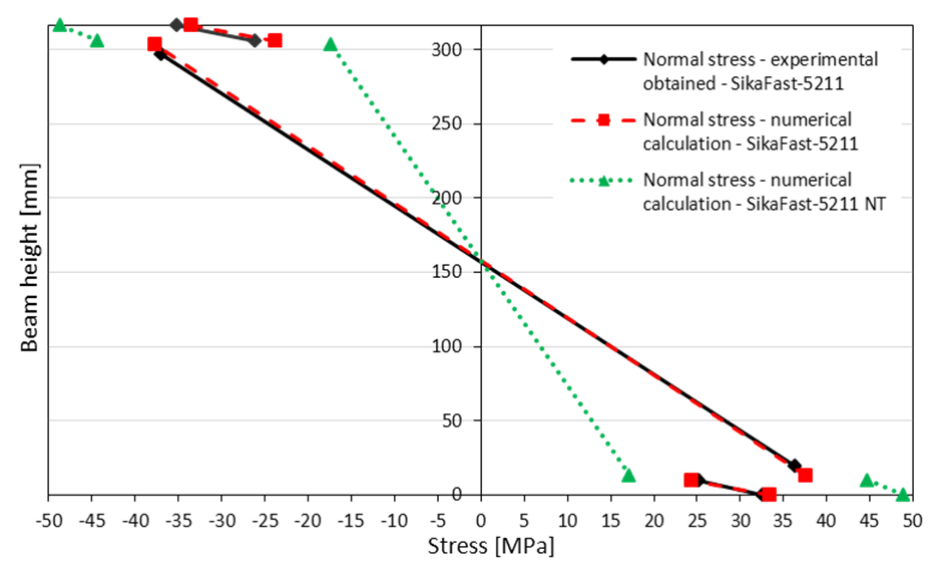
Fig. 14 Normal stress in cross-section of the hybrid beam under bending moment 18.9 kNm, comparison of experiment and numerical